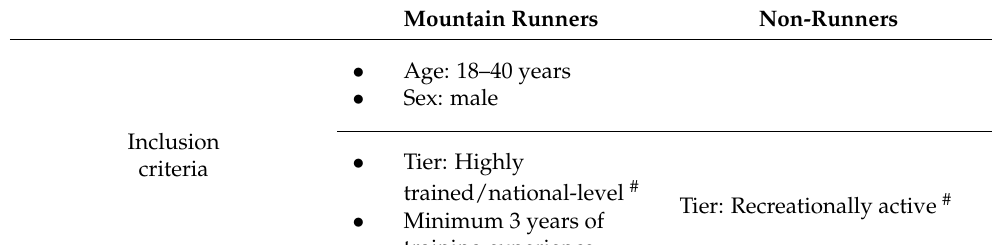
Table 2. Inclusion and exclusion criteria for the